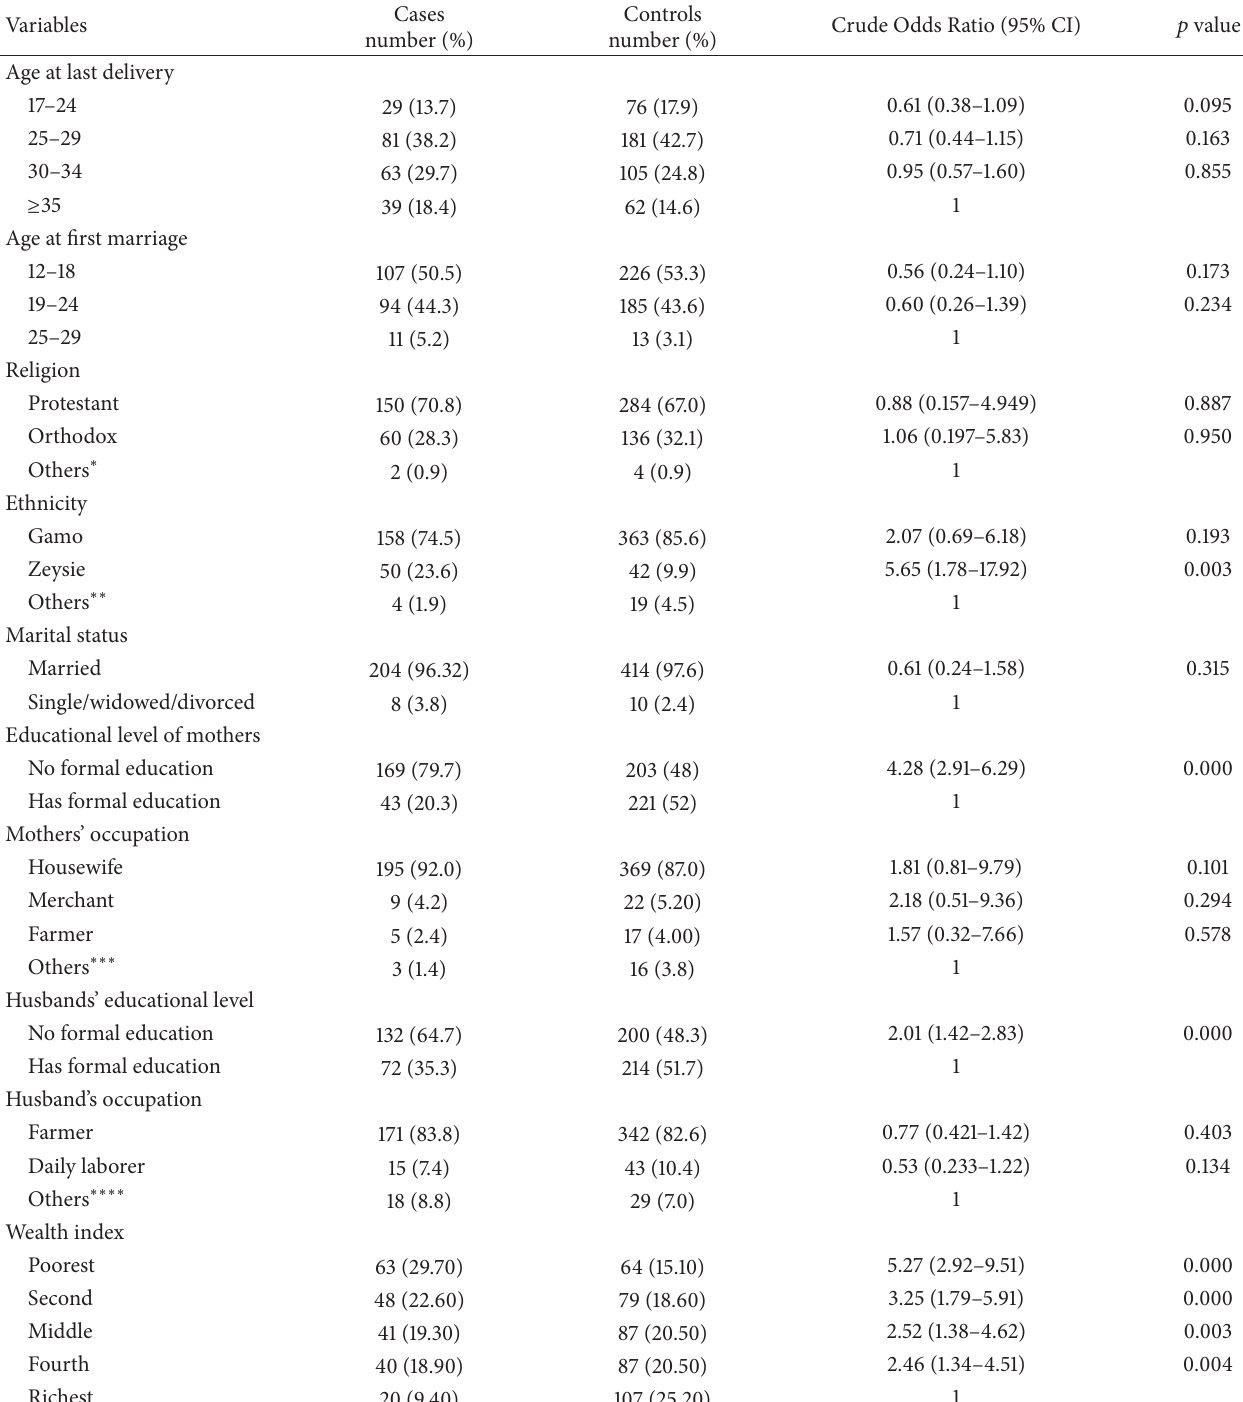
Table 1: Univariate and bivariate analysis of socioeconomic characteristics of child-bearing age mothers in Arba Minch Zuria District, Gamo Gofa Zone, Ethiopia,